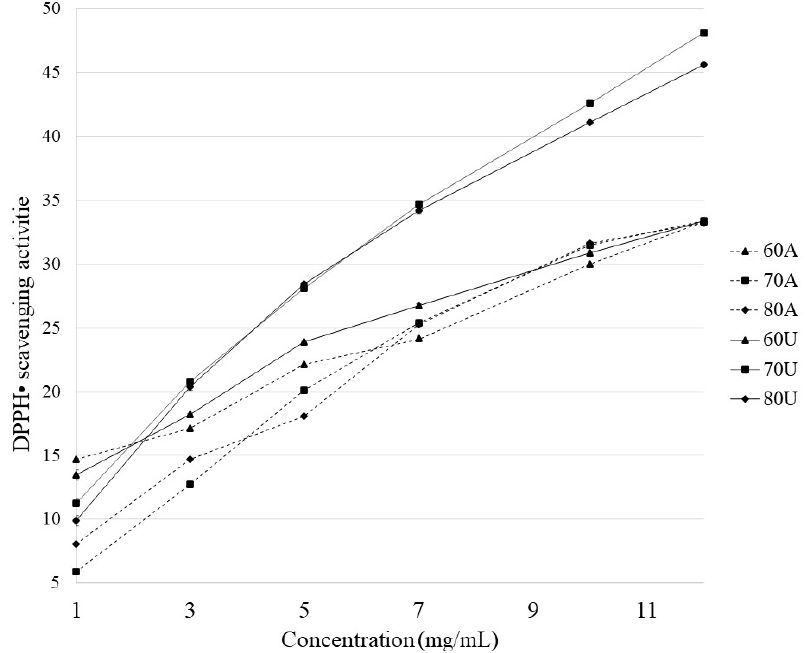
Figure 3. DPPH free radical scavenging of pectins extracted from kaffir